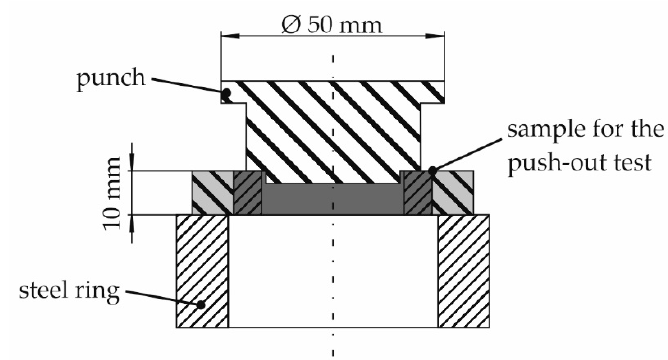
Figure 4. Schematic illustration of the experimental setup of the push-out tests using a sample taken from a hollow compound profile.